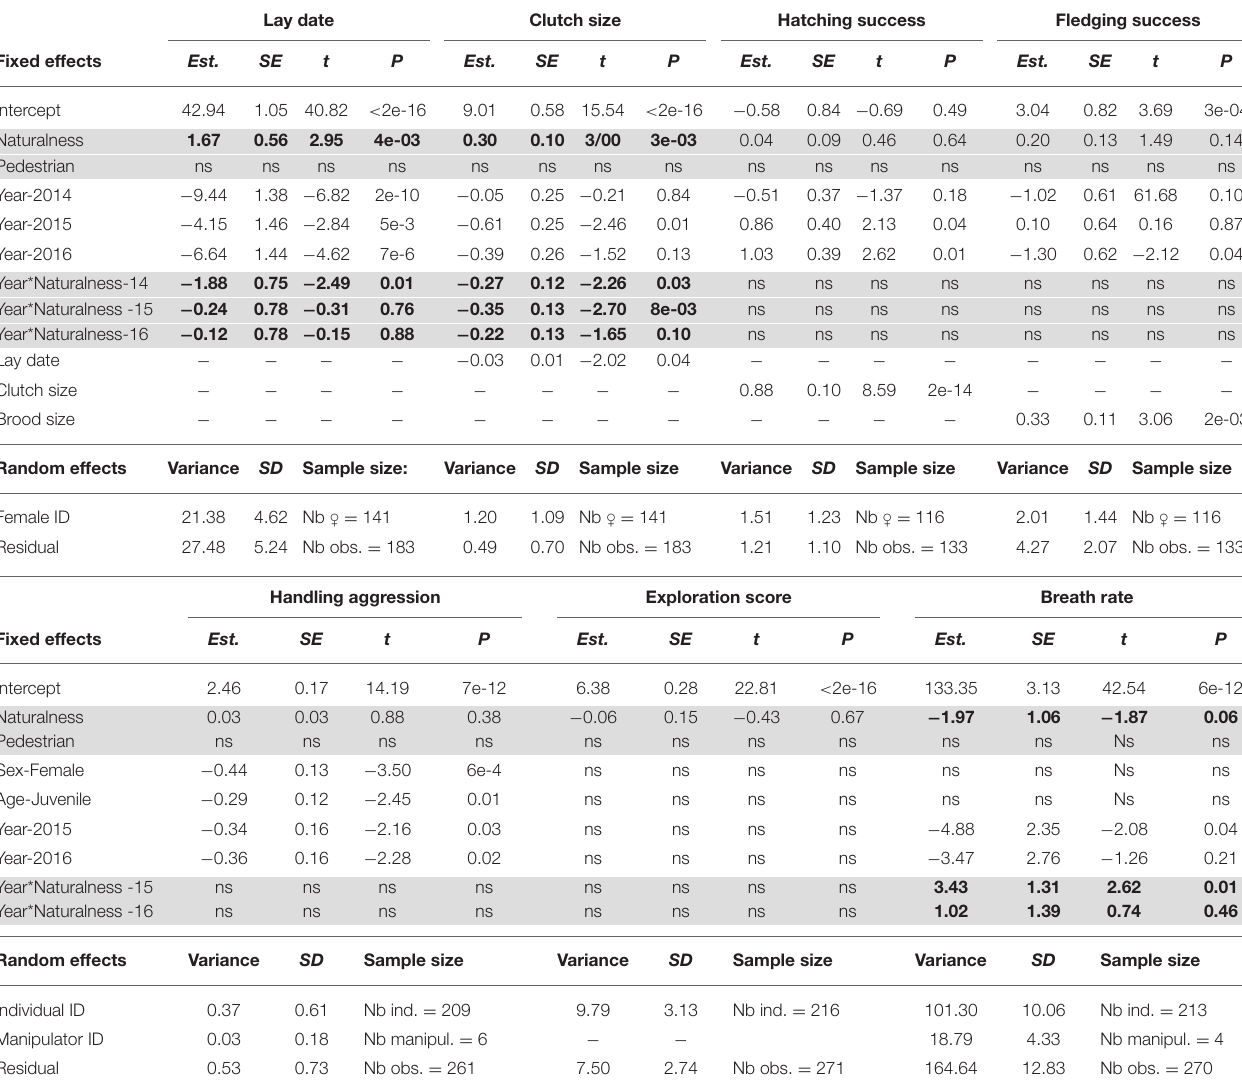
TABLE 4 | Contrasting phenology, reproductive success, behavior, and physiology along urban gradients of habitat naturalness (Naturalness) and pedestrian frequency (Pedestrian) using linear mixed models with female/individual identity and manipulator identity (for handling aggression and breath rate) as random effects. Clutch